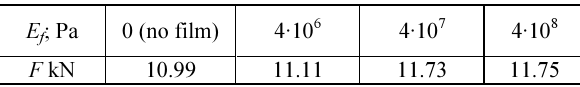
Table 4. Force reaction of numerical Marshall